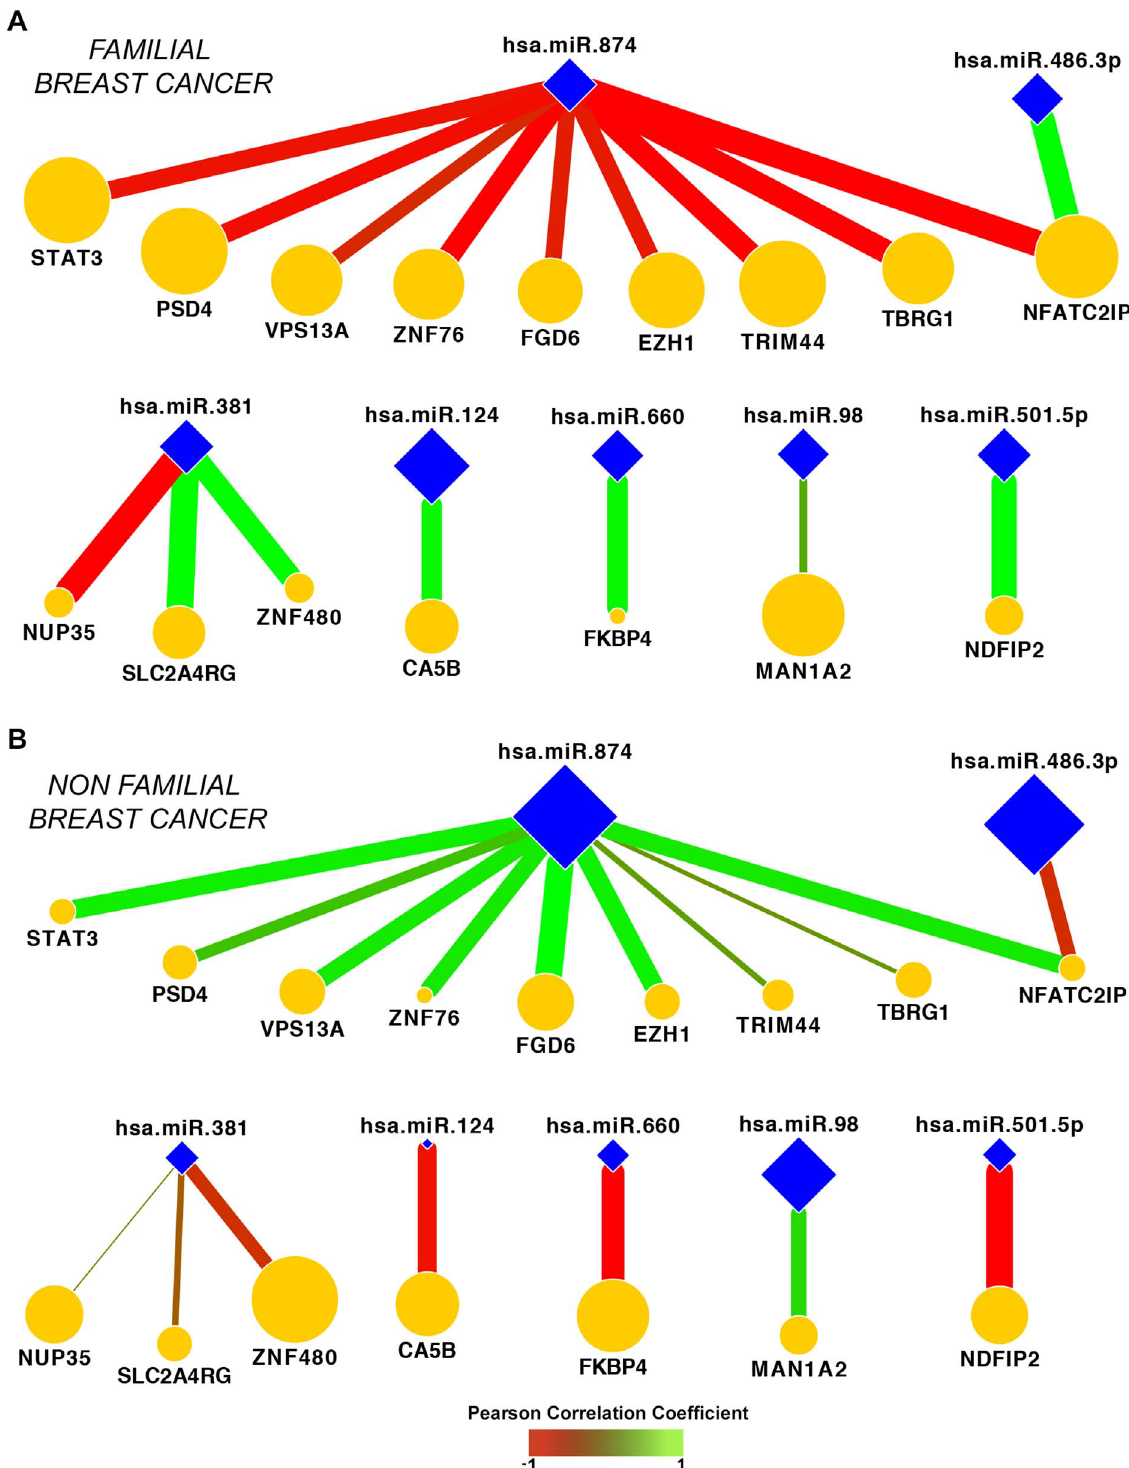
Figure 4. Illustration of network signatures. Seventeen miR–mRNA predicted interactions whose co-expression are significantly different between F-BC (A) and NF-BC (B) groups. Color edges represent positive (green) or negative (red) Pearson correlation values. The edge thickness indicates the magnitude of Pearson correlation values. The node size is proportional to the fold change of genes (orange nodes) and of miRs (blue nodes) between F-BC to NF-BC groups. F-BC, familial breast cancer; NF-BC, non-familial breast cancer.